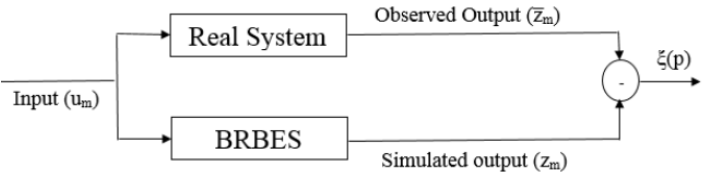
Figure 2. Optimal learning process of